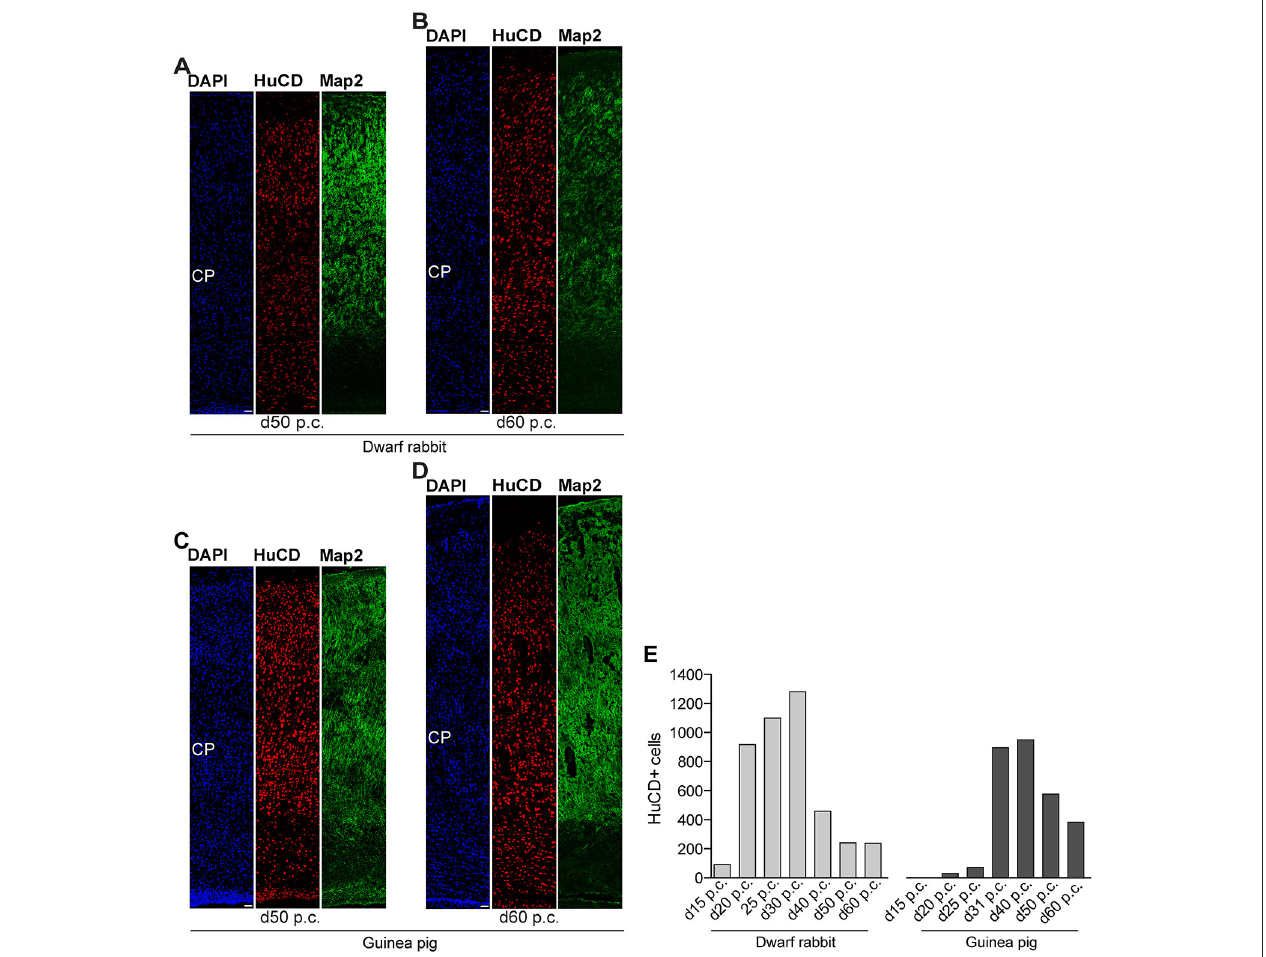
FIGURE 7 | Hu C/D and Map2 expression in the developing dwarf rabbit and guinea pig neocortex. (A–D) Double immunofluorescence for Hu C/D (red) and Map2 (green) and DAPI staining (blue) on 30- µ m cryosections of day 50 and 60 post-conception (p.c.) dwarf rabbit (A,B) and guinea pig (C,D) neocortex. Scale bars, 50 µ m. CP, cortical plate. (E) Quantification of Hu C/D + cells in d15–50 p.c. dwarf rabbit (light gray) and d20–60 p.c. guinea pig (dark gray) cortical wall, expressed as the number of cells per 100 µ m ventricular surface. The cortical wall corresponding to a total ventricular surface of 3.86–6.02 µ m (guinea pig) and 3.08–6.05 µ m (dwarf rabbit) was analyzed. Data are from one brain each.